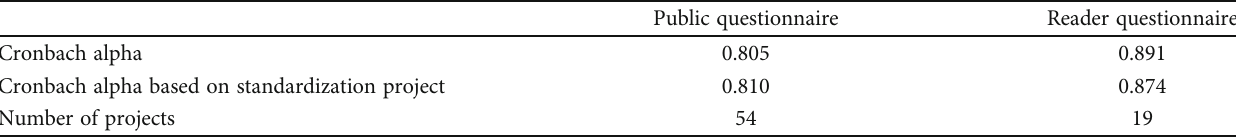
Table 1: Reliability analysis table of the